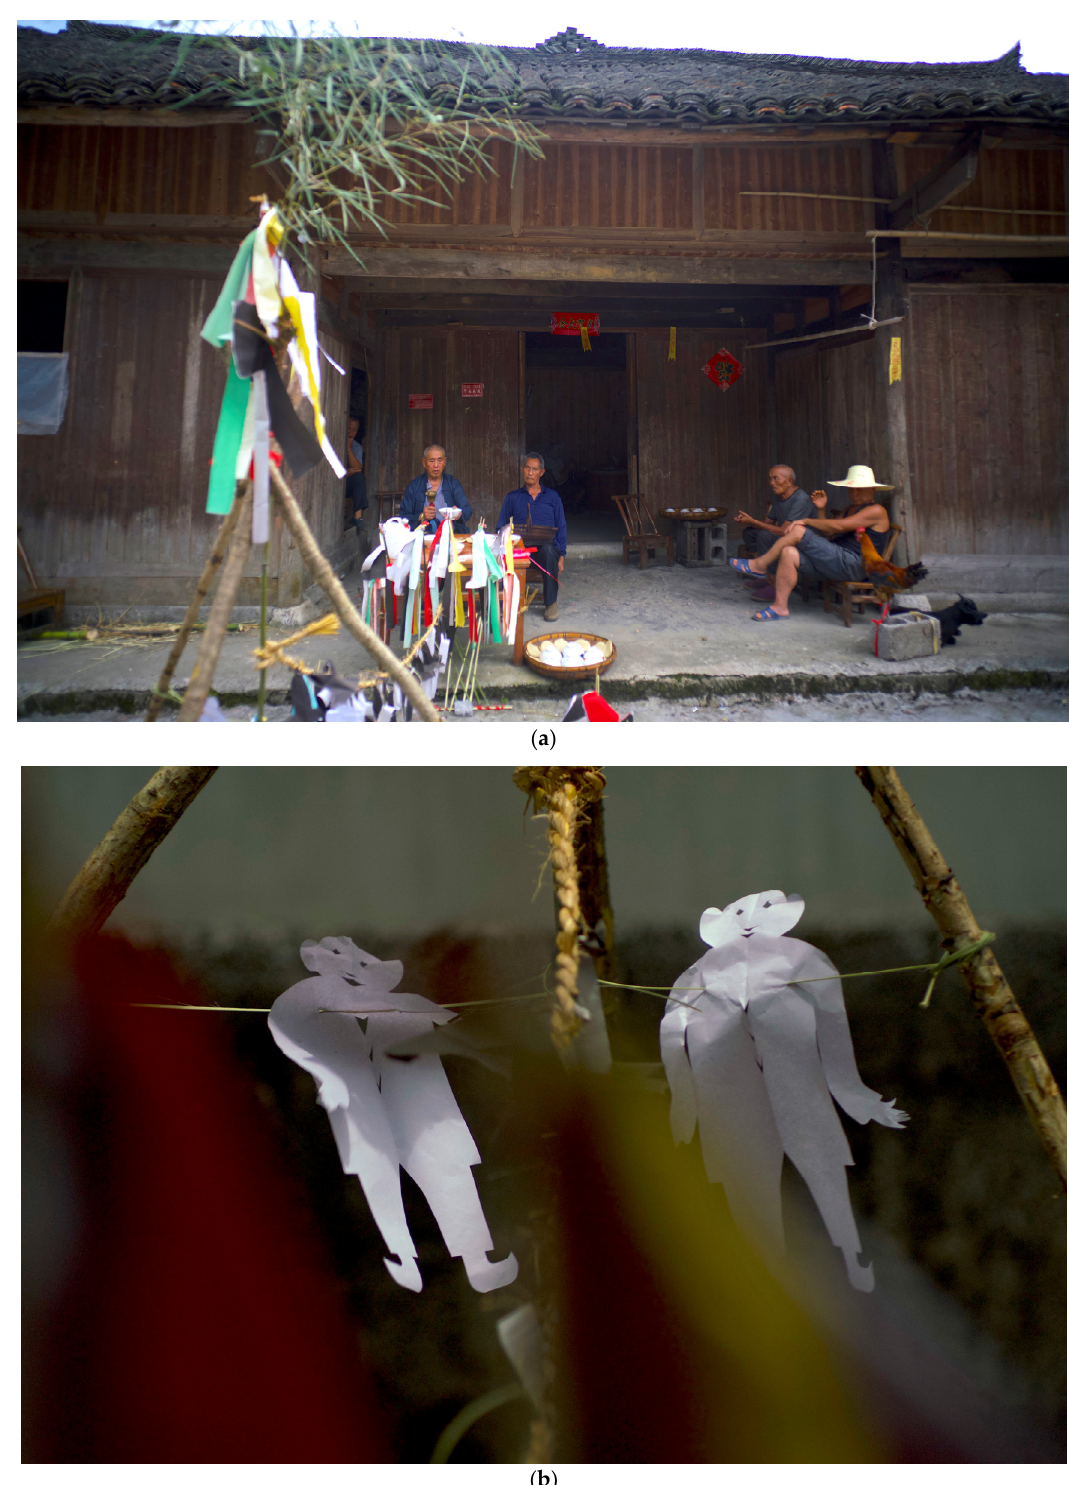
Figure 10. ( a , b ) The tali tree altar. ( b ) Note the tali tree branch and the anthropomorphic figures symbolizing spirits. (Photo: Thomas Riccio).